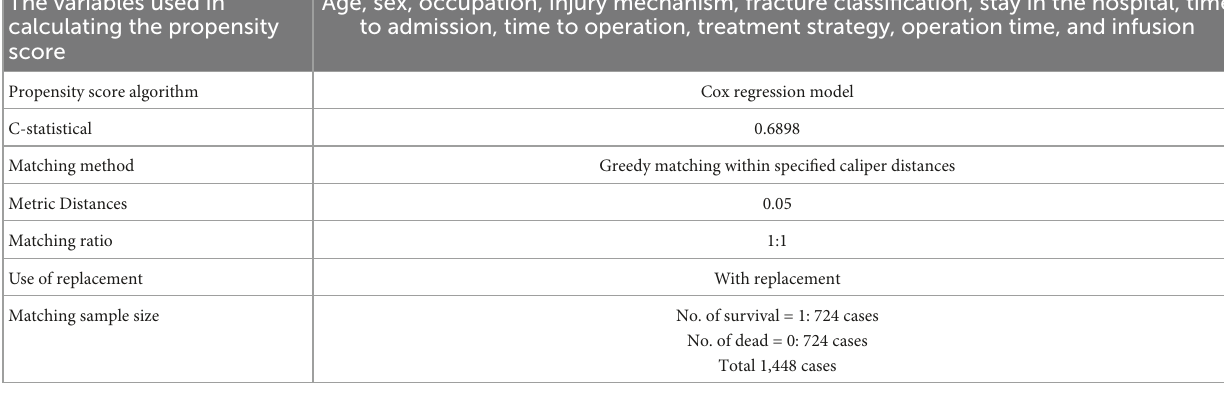
TABLE 5 Propensity score parameter